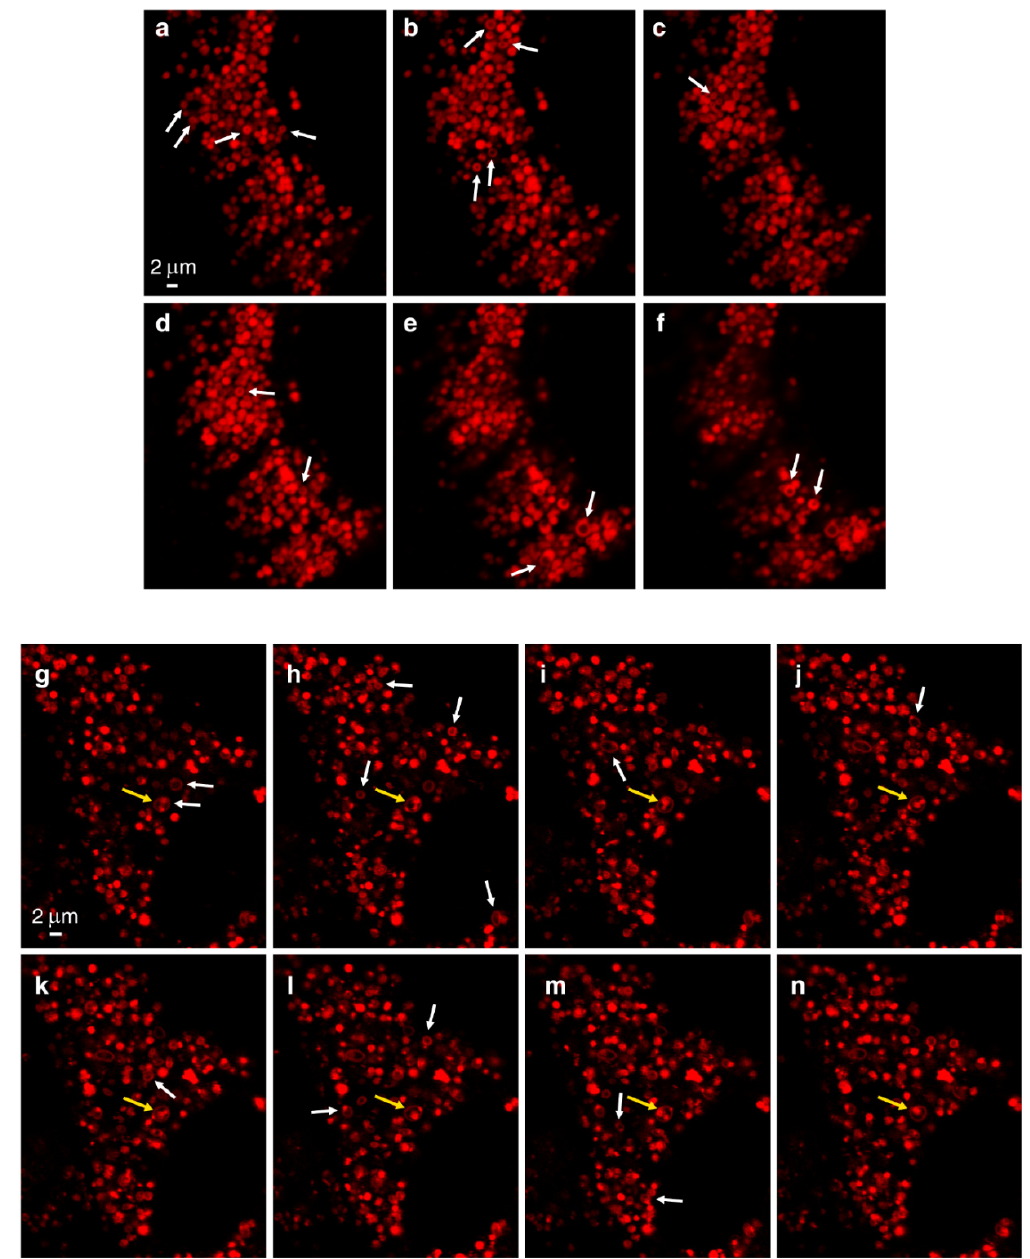
Figure 2. Z-Stack analysis of LTR-loaded lysosomes. Clomp R cells ( a – f ) or vacuolin-1-treated U2OS cells ( g – n ) were labeled with LTR and scanned with a confocal Zeiss LSM 710 microscope (×63 magnification) using focus stacking with 0.2 μ m slices. White arrows indicate ring-like structures as they first appear. The yellow arrow points to a lysosome harboring internal vesicles.